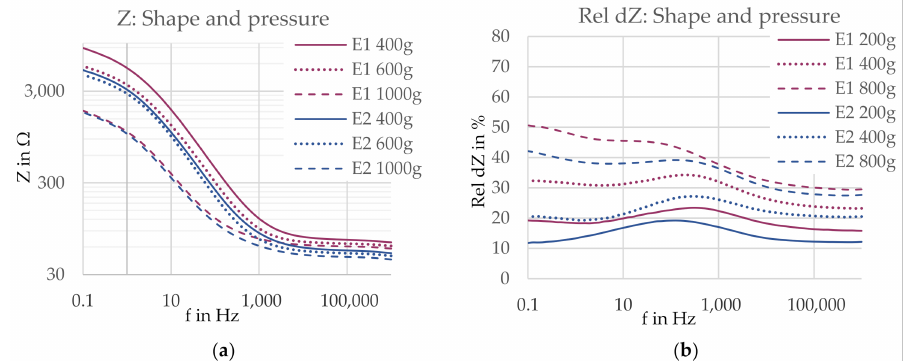
Figure 16. ( a ) Contact impedance Z and ( b ) impedance change rel dZ for electrodes with a circular shape (E1, 17.4 cm 2 , pink) and a rectangular shape (E2, 17.4 cm 2 , blue). Electrode versions are marked with different colors, and pressure levels are marked with different line styles.